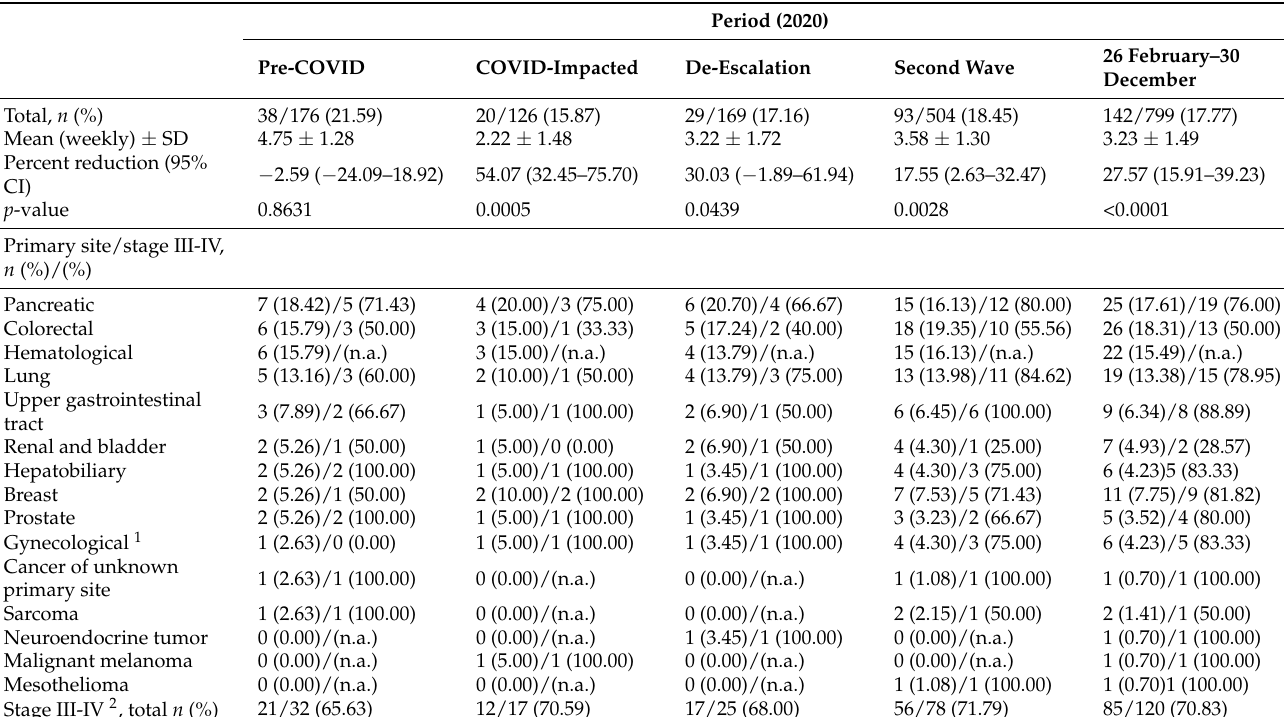
Table 4. Cancer sites and stages across study periods in